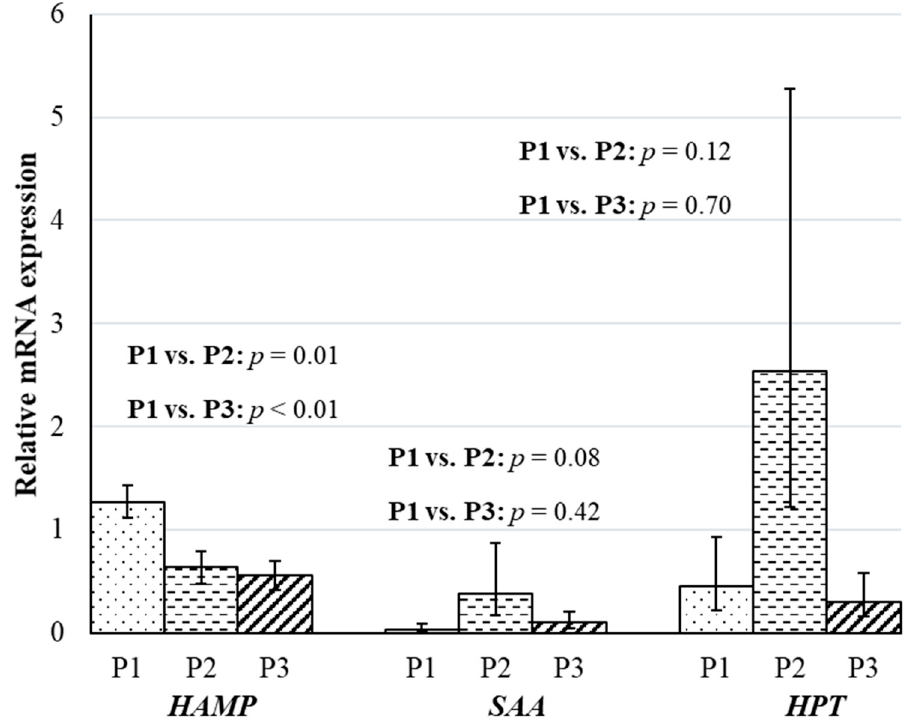
Figure 1. Impacts of time-fed concentrate-based diets on relative mRNA expression of hepatic positive acute phase reactants of wethers. The experiment was divided into three phases: P1 (day 0 to 21), P2 (day 22 to 25), and P3 (day 22 to 49). During P1, all wethers ( n = 13) were fed the 80% forage diet. On day 22, the remaining nine wethers were fed an 80% concentrate diet. The contrasts between wethers sampled in P1 ( n = 4) and P2 ( n = 4) and between wethers sampled in P1 ( n = 4) and P3 ( n = 5) on least square means of relative mRNA expression of Hepcidin ( HAMP ), Serum α -amyloid ( SAA ) and Haptoglobin ( HPT ) in liver tissue. Least-squares means and standard error of means for HPT and SAA expression were back-transformed for the presentation of results. Least-squares means and standard error of means before back transformation for SAA and HPT are presented in S2.